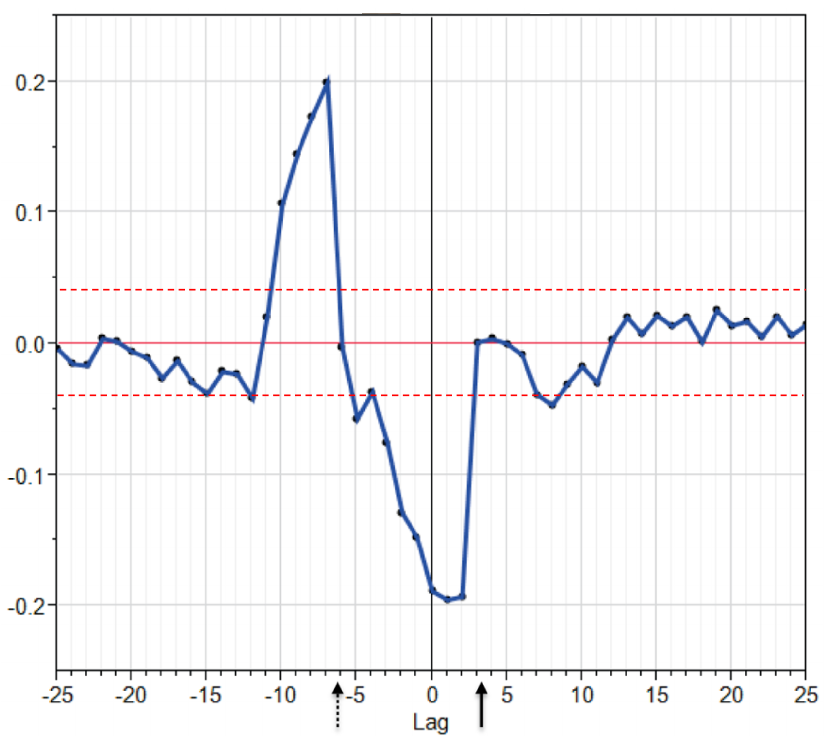
Figure 4. Cross correlation of cathepsin L cleavage probability and B cell epitope probability in tetanus toxin. Index position zero corresponds to the N-terminal amino acid (P4) of the cleavage site octomer of cathepsin. Hence the scissile bond P1-P1’ occurs at positions 3–4 (solid arrow). The B-cell epitope prediction algorithm evaluates each amino acid in the context of the 4 amino acids each side hence showing the probability that the center amino acid of a 9-mer is a B epitope contact point that will be at index position zero in this graphic. The predictions suggest a strongly negative correlation with cathepsin cleavage to amino acid position running from the predicted cleavage point to -6 (dashed arrow), or that the probability of the peptide whose N terminus is at the position is not favorable for cutting by the peptidase in this region. The dashed lines at 6 0.04 indicate the 95 th percentile confidence limits for non significant correlation; values outside this band are significant p , 0.05.The corresponding plot for all 11 proteins is shown in Figure